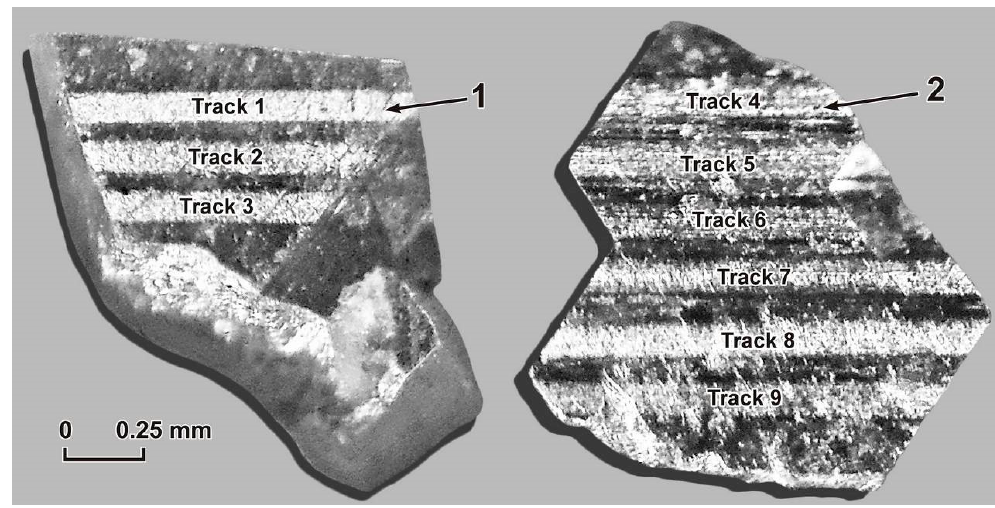
Figure 12. Arsenopyrite Crystals 1 and 2 (sample UV-3/13) from ores of the Natalkinskoe deposit. Tracks 1–9, numbers of laser passes over the crystal surface. The results of LA-ICP-MS analysis are presented in Table 12.